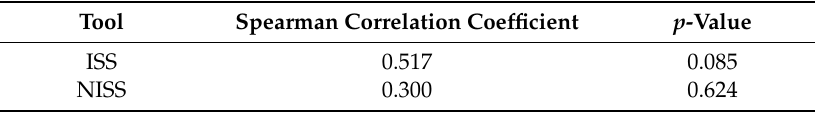
Table 2. Test of the threshold effect.